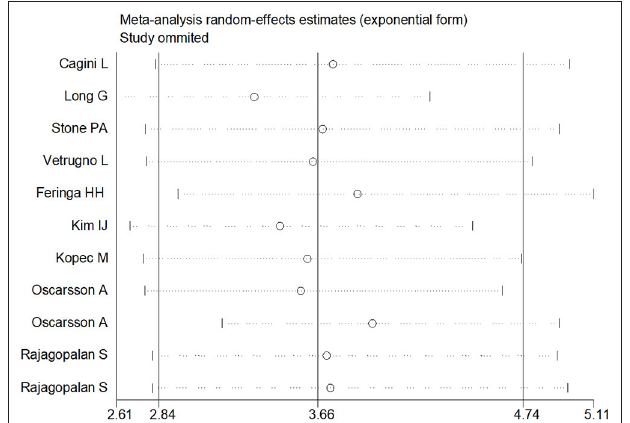
FIGURE 5 | Sensitivity analysis in BNP and NT-proBNP.